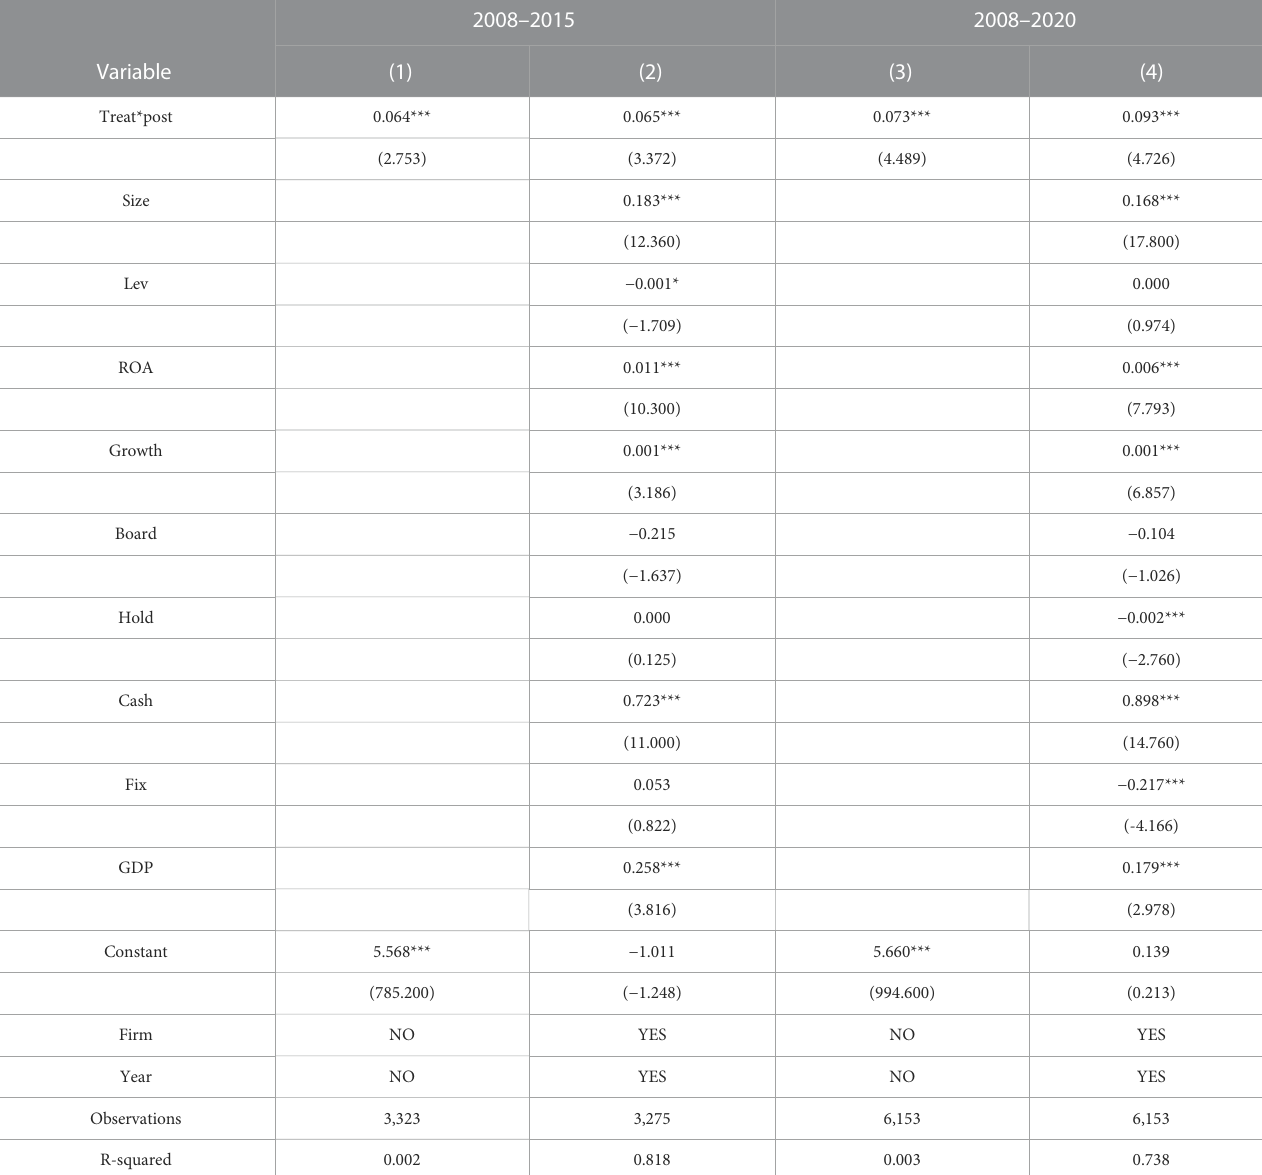
TABLE 4 Regression results of the impact of green credit policy on enterprise technological